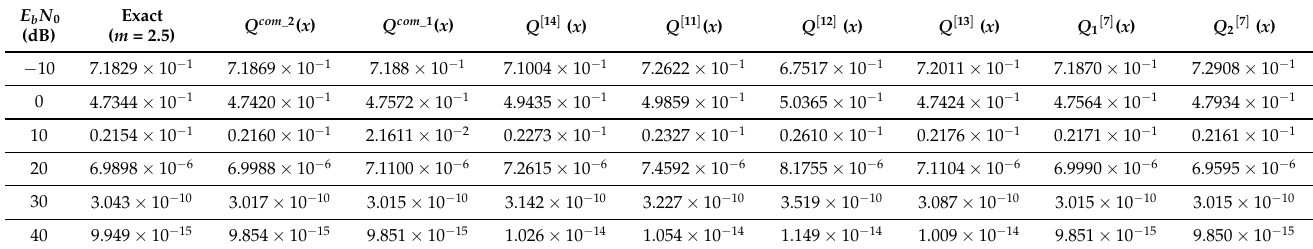
Table 8. Values of the exact and approximated ASEP of the DE-QPSK for parameter m =